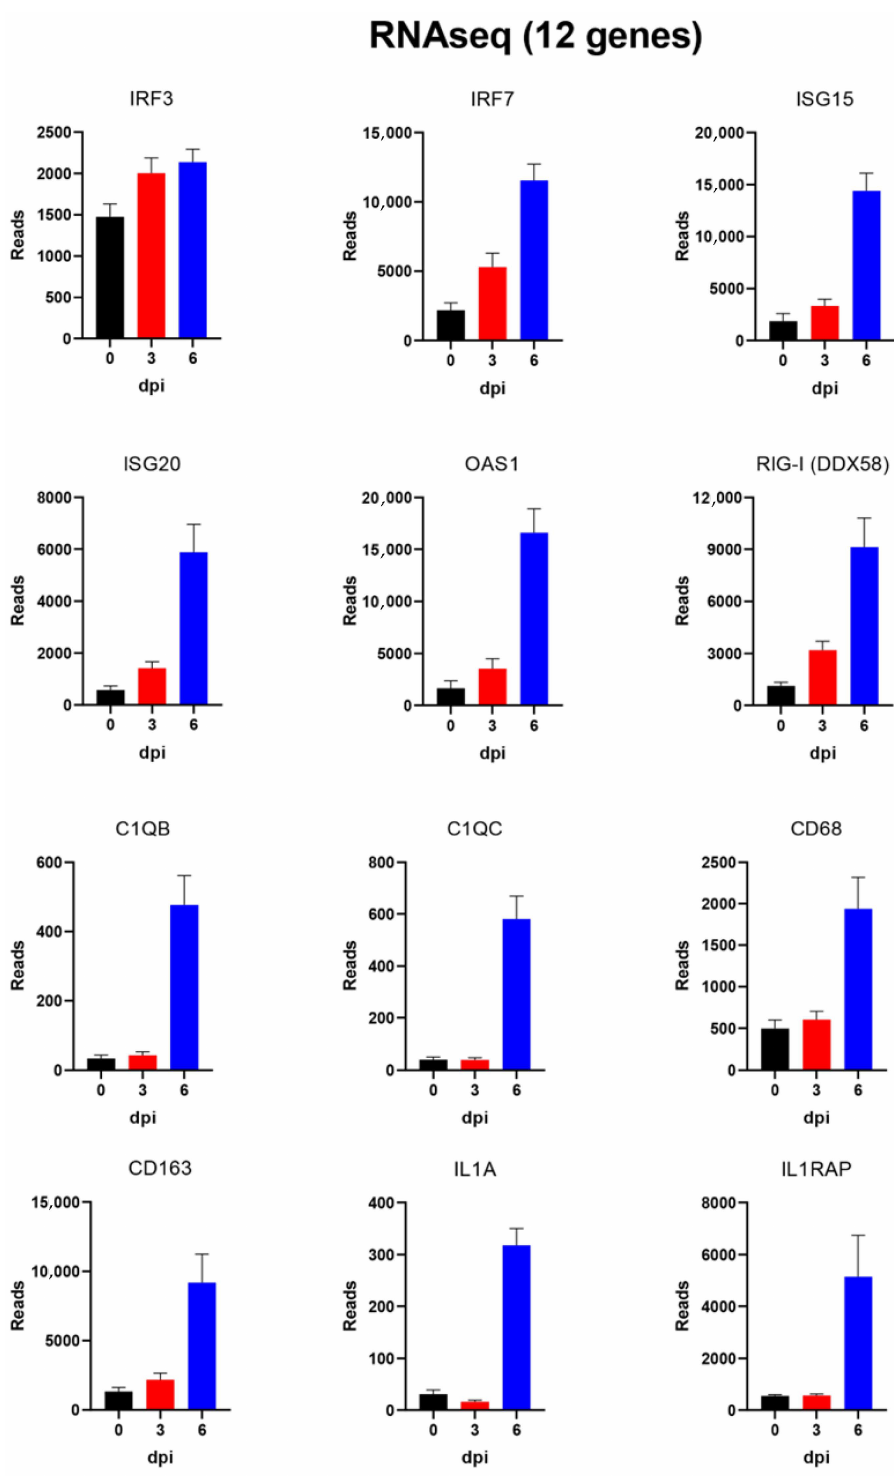
Figure 5. Expression of 12 selected host genes in PBMCs from ASFV-infected pigs as determined by RNAseq. The normalised numbers of gene sequence reads (mean of 4 pigs +SEM) for these selected genes are shown for the PBMCs collected at 0, 3 and 6 dpi. All of these genes (except for IRF3) were expressed at >3–10-fold higher levels at 6 dpi compared to 0